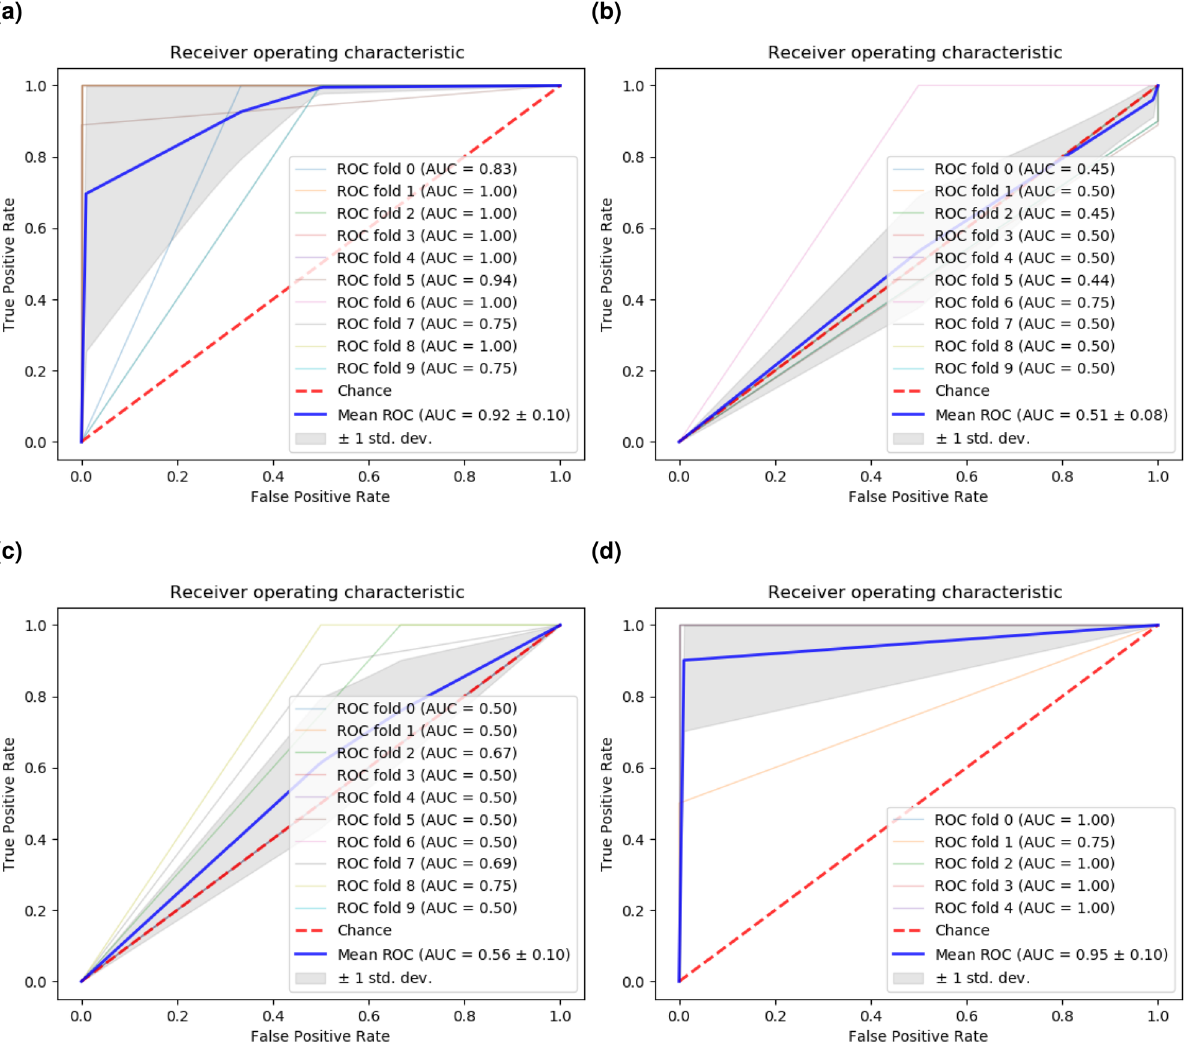
Figure 2. ROC curves for ( a ) REFS, ( b ) IWGCNA, and ( c ) univariate analysis applied to the same mRNA expression data of 118 samples from the CAMDA dataset. ( d ) ROC curve for the validation of the obtained 23-gene signature on a separate dataset (GSE14577). The 5-fold cross validation was performed with the eighteen genes available in ABCE1, PHKA2, IL2RB, CCR4, HLA-DQA1, PRG4 and OGG1, that acted in immune pathways. The mRNA transcripts encoding these proteins were all downregulated in ME/CFS patients compared to healthy controls (Fig. 1a). Protein functions are visualized in Fig. 4 and briefly described below.